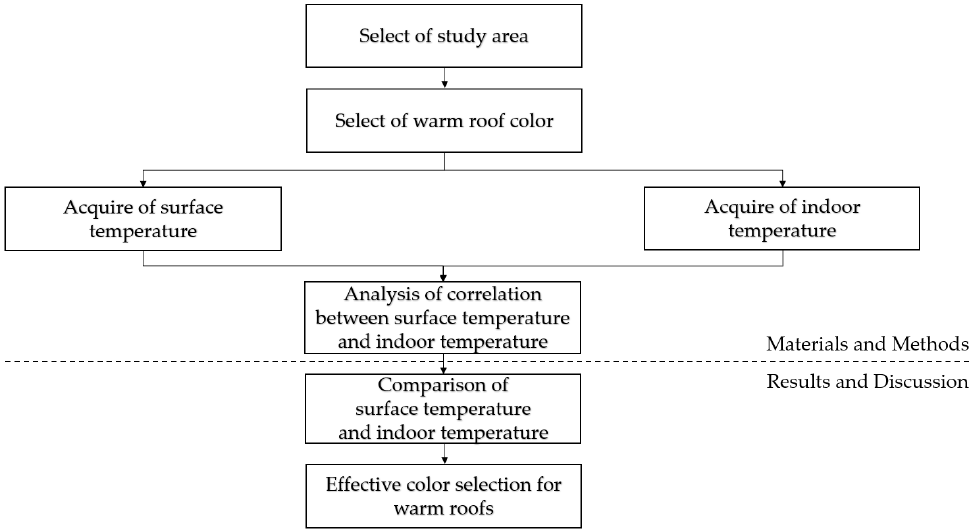
Figure 1. Research flow chart.